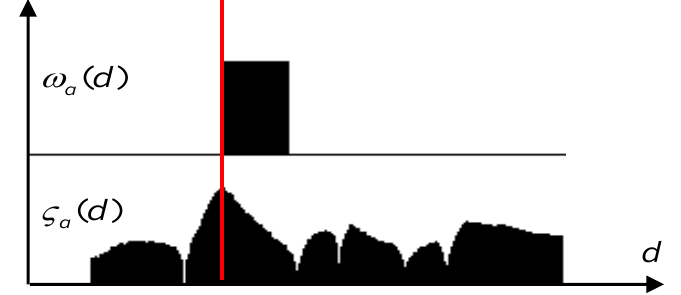
Figure 4. Finding the obstacle’s position along a ray.